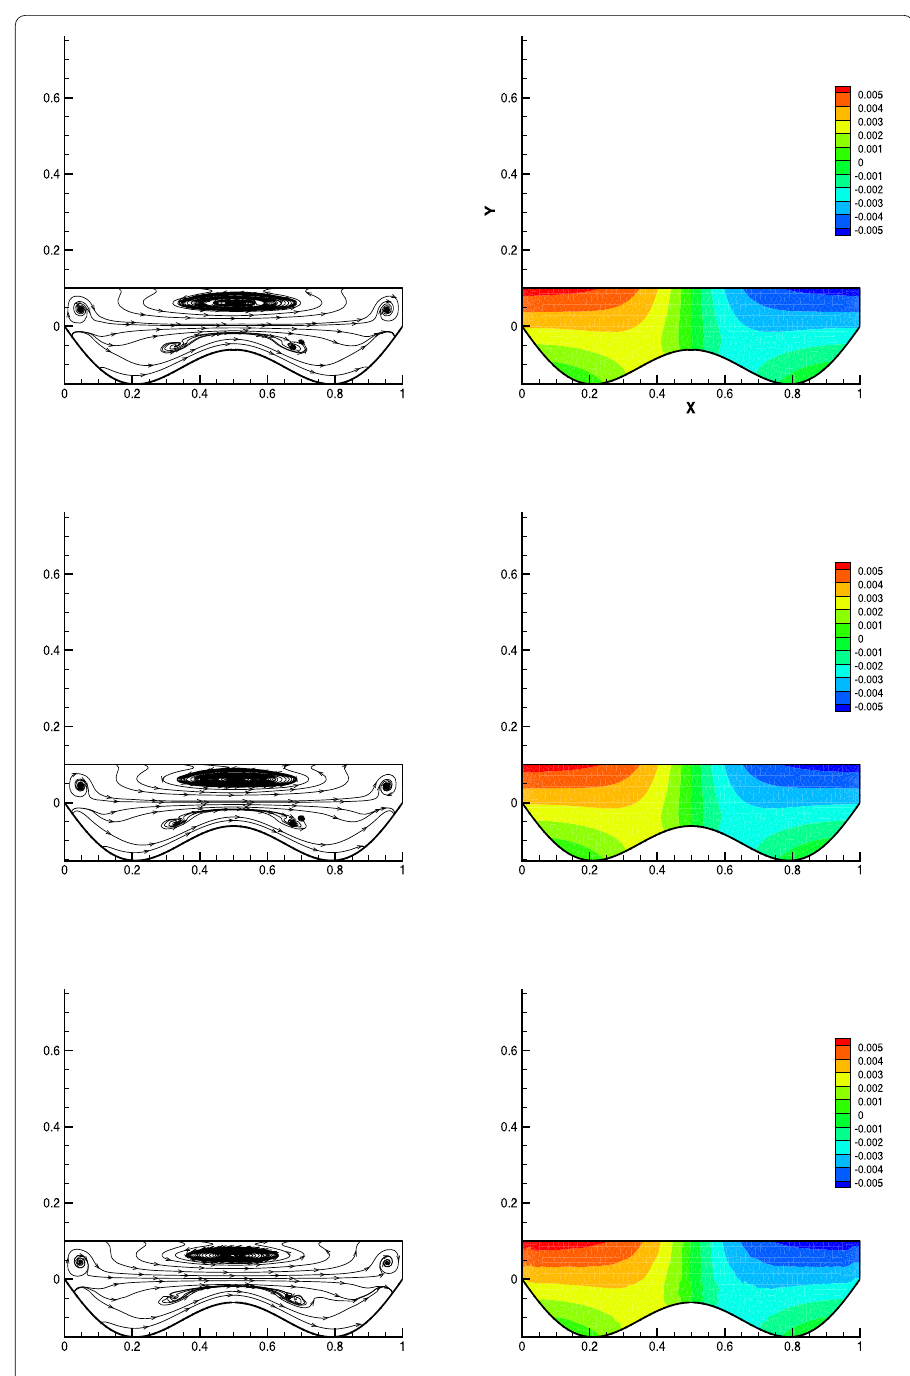
Figure 1 The numerical streamlines and isobars: the stabilized P 2 – P 2 pair (the first line), the P 2 – P 1 pair (the second line) and the stabilized P 1 – P 1 pair (the third line)